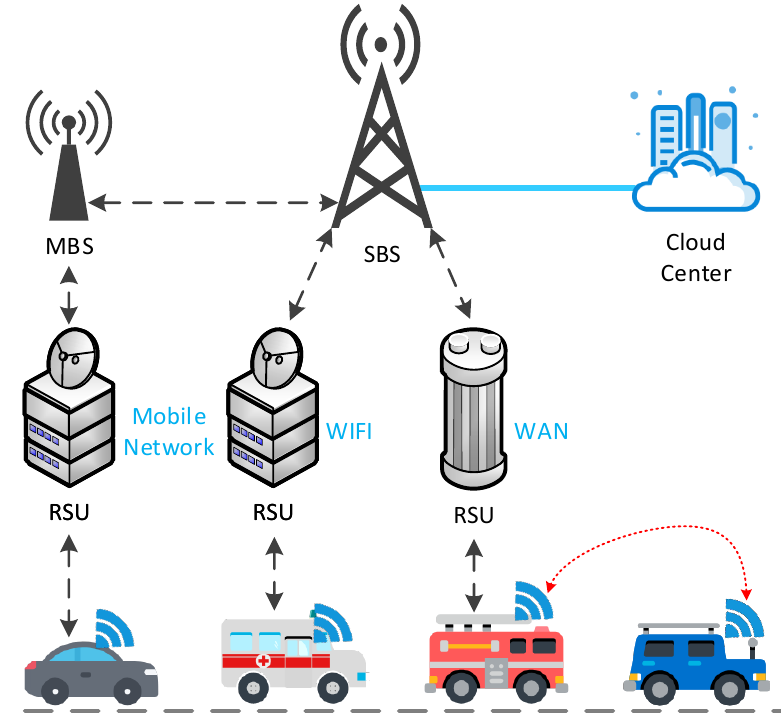
Figure 9. Edge caching in